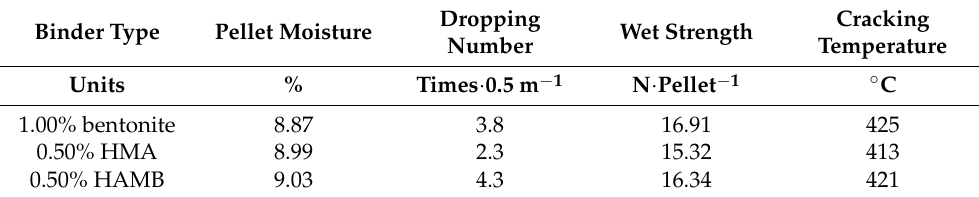
Table 5. Properties of prepared green